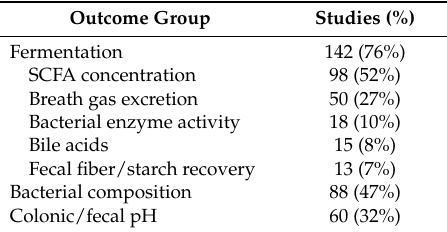
Table 3. Microbiota outcomes (total studies = 188).